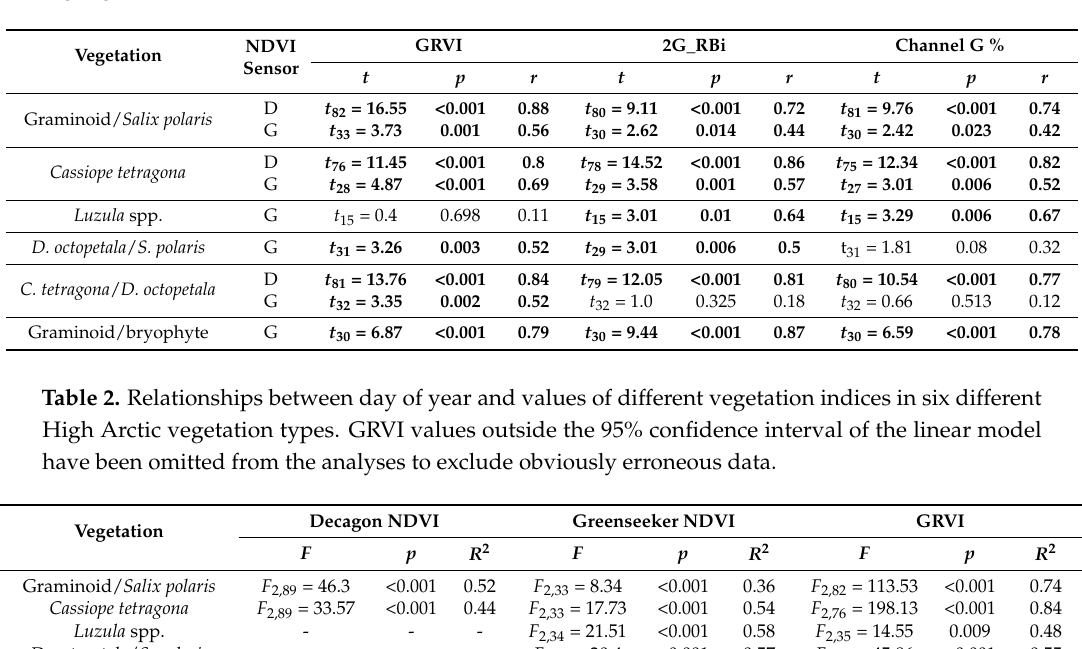
Table 1. Pearson’s correlations between NDVI and three different RGB greenness indices in six different High Arctic vegetation types. The NDVI measurement instruments used were Decagon sensors (D) and a Greenseeker device (G). Greenness index values outside the 95% confidence interval of the linear model have been omitted from the analyses to exclude obviously erroneous data. t = t -statistic t n = the valid sample numbers after filtering the time serial data. Statistically significant relationships are highlighted in bold.